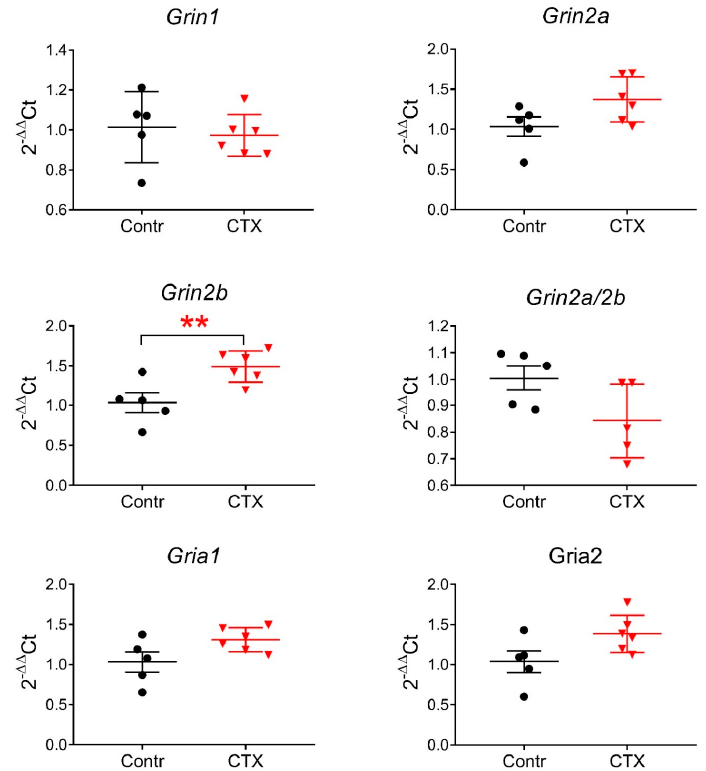
Figure 4. The relative expression of the Grin1 , Grin2a , Grin2b , Gria1 , Gria2 genes, and Grin2a / Grin2b ratio in the dorsal hippocampal area after CTX treatment. Contr—control group, CTX—experimental group. Data are presented as a mean with a standard error of the mean. Each dot (circle, triangle) represents a value obtained in individual animal. ** p < 0.01, a significant difference versus the control group according to the Student’s t -test.